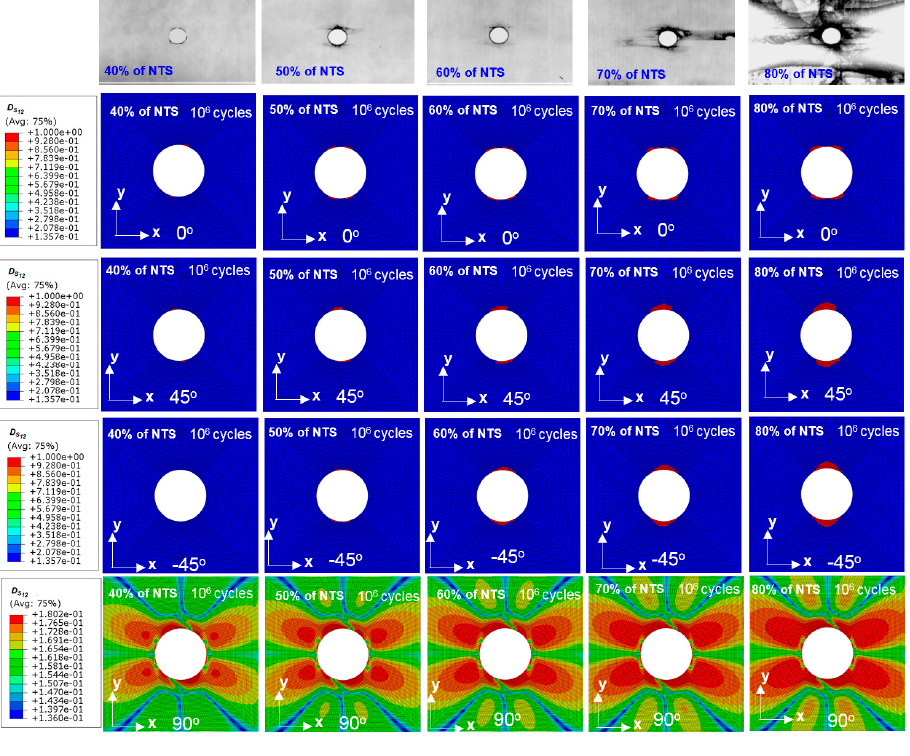
Figure 17. Reduction in strength S 12 in each ply of the OHT specimen after 10 6 cycles. J. Compos. Sci. 2018 , 2 , x FOR PEER REVIEW